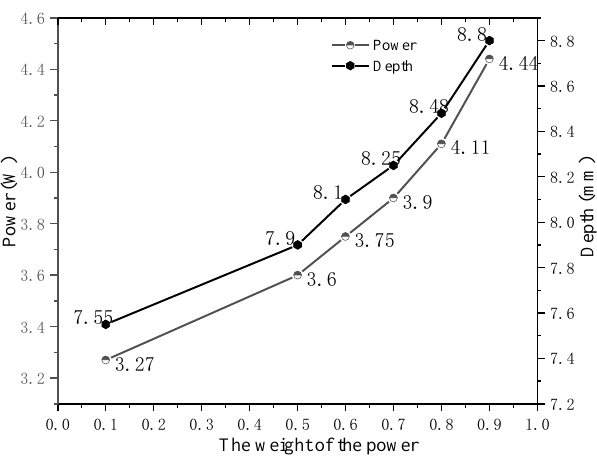
Figure 7. Motor thickness optimization.